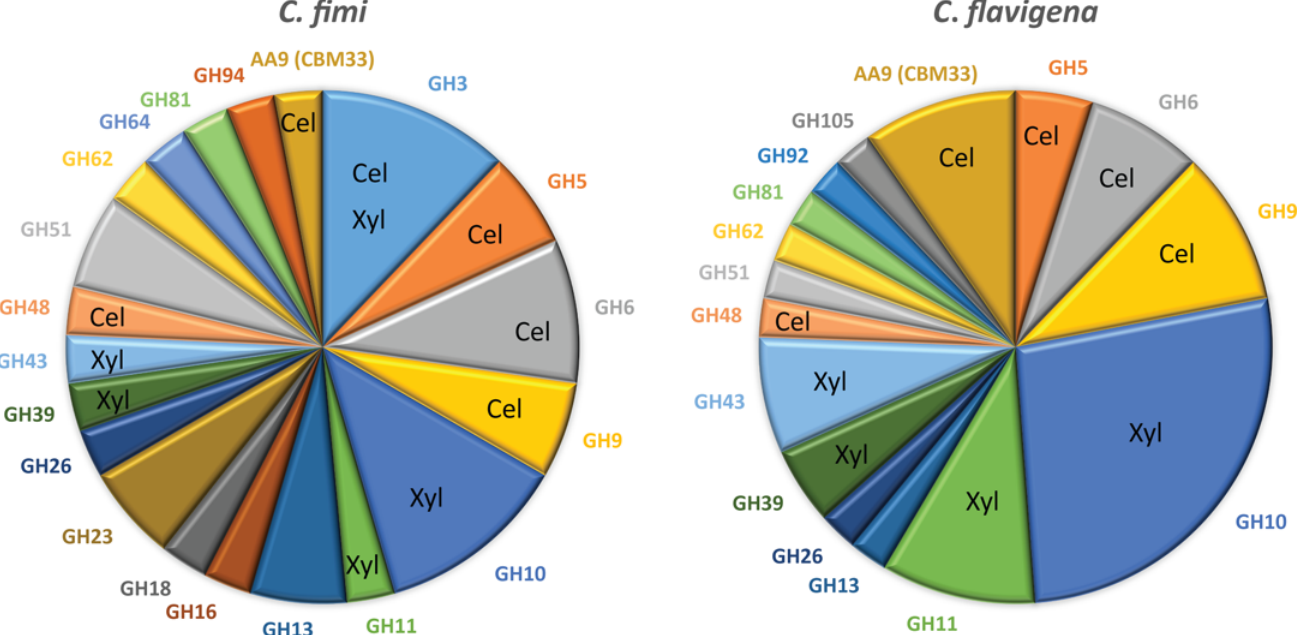
Fig 4. Summary of the observed CAZyme content. In order to facilitate visual comparison of the supernatant CAZymes, we summarized the content by enzyme family in a pie chart. Each family that had at least one member is plotted as a different coloured section of the chart. Those families that have known activities toward cellulose or xylan degradation are labelled with “ Cel ” or “ Xyl ” . The sections are proportional to the number of family members that were identified in each